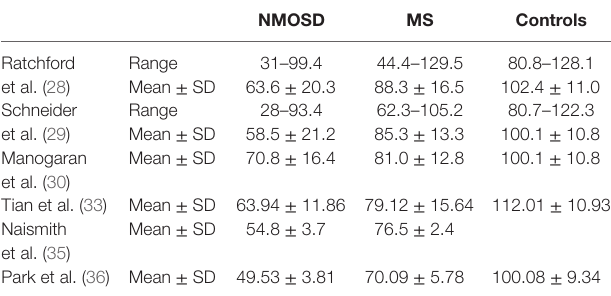
Table 1 | Average peripapillary retinal nerve fiber thickness (in micrometers) after optic neuritis in patients with neuromyelitis optica spectrum disorders (NMOSD), multiple sclerosis (MS), and healthy